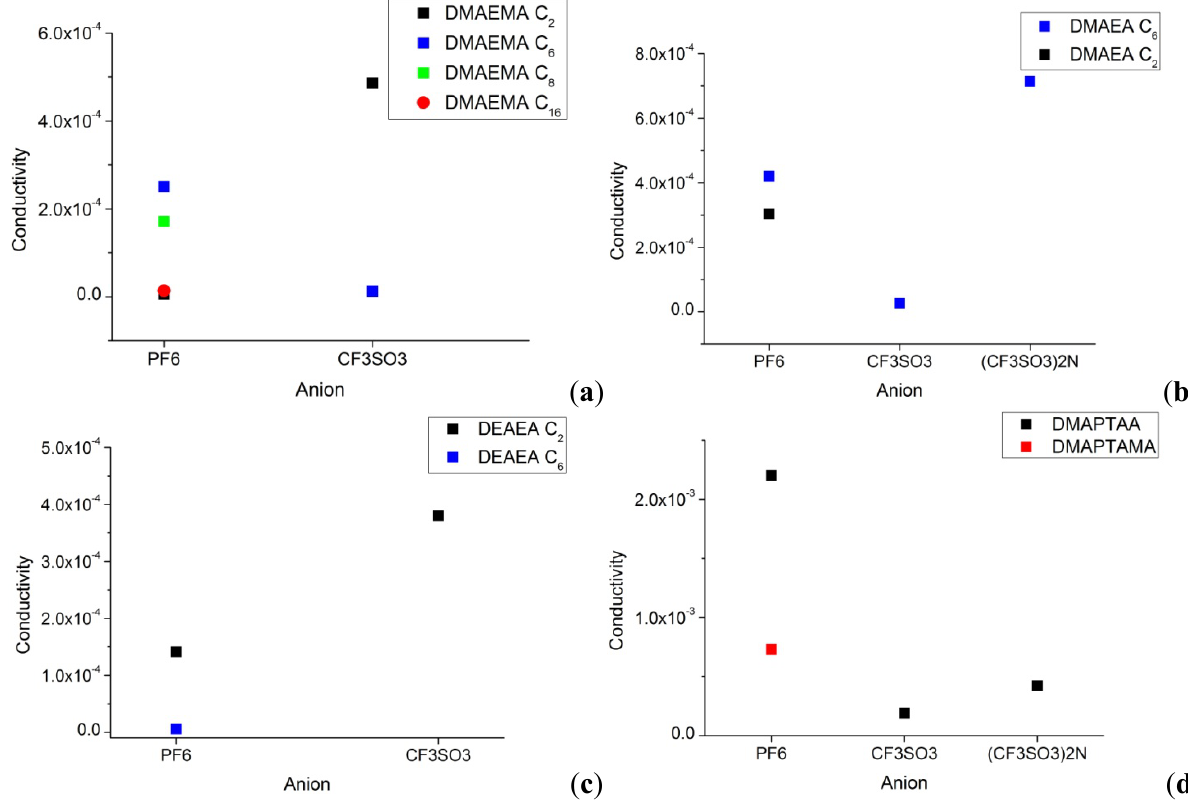
Figure 2. Conductivity vs. anion ( a ) DMAEMA with C ( b ) DMAEA with C length. ( d ) Dicationic ionic